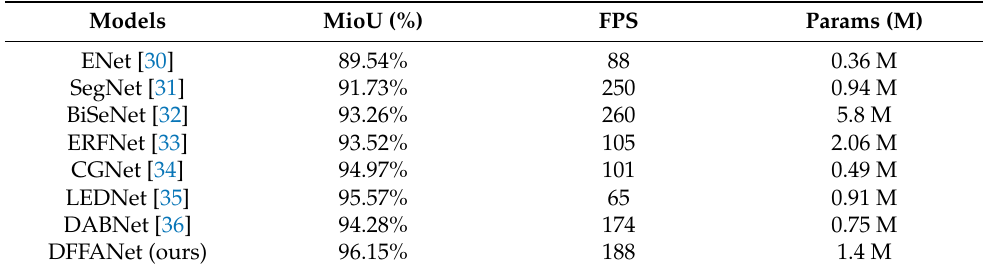
Table 2. Performance comparison with existing